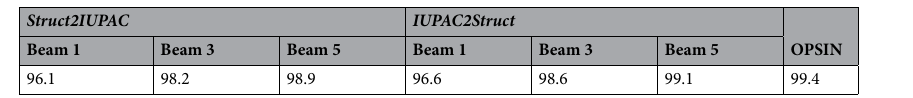
Table 1. Accuracy (%) of models on the test set of 100k molecules with different beam size.